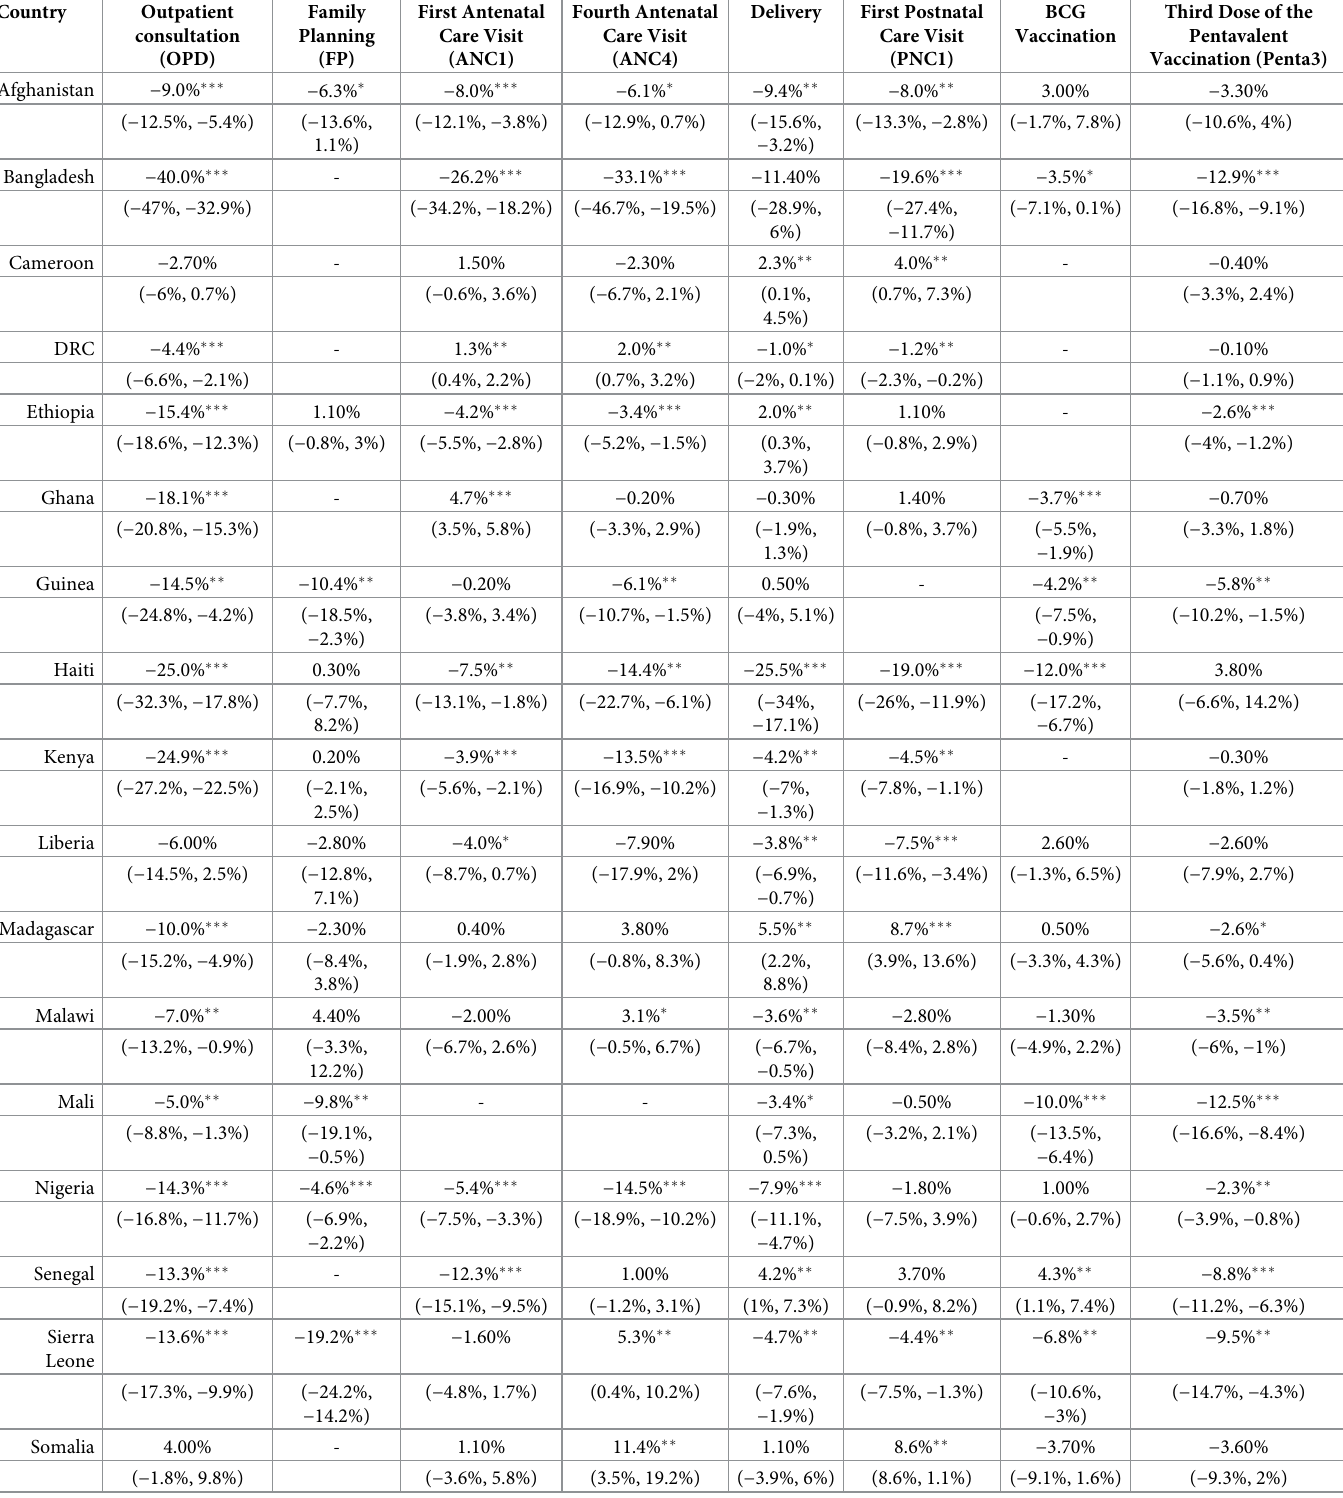
Table 2. Cumulative change in service volumes during the pandemic period (March 2020–June 2021) compared to expected volume based on prepandemic